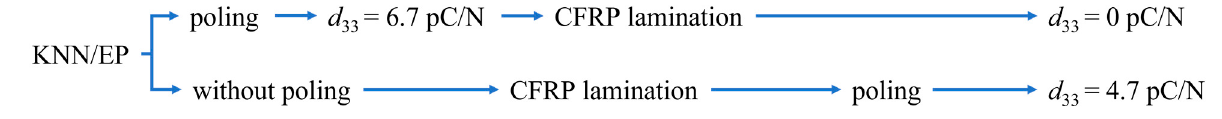
Figure 8. Processes and results of the two fabrication methods.